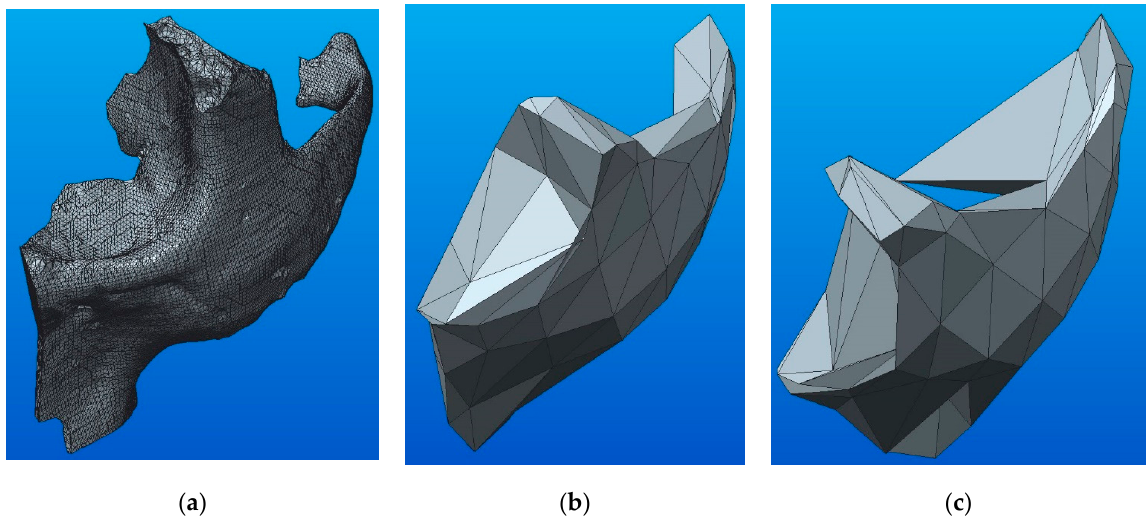
Figure 5. Level of approximation: ( a ) level 10; ( b ) level 1; ( c ) malfunctioned solid.